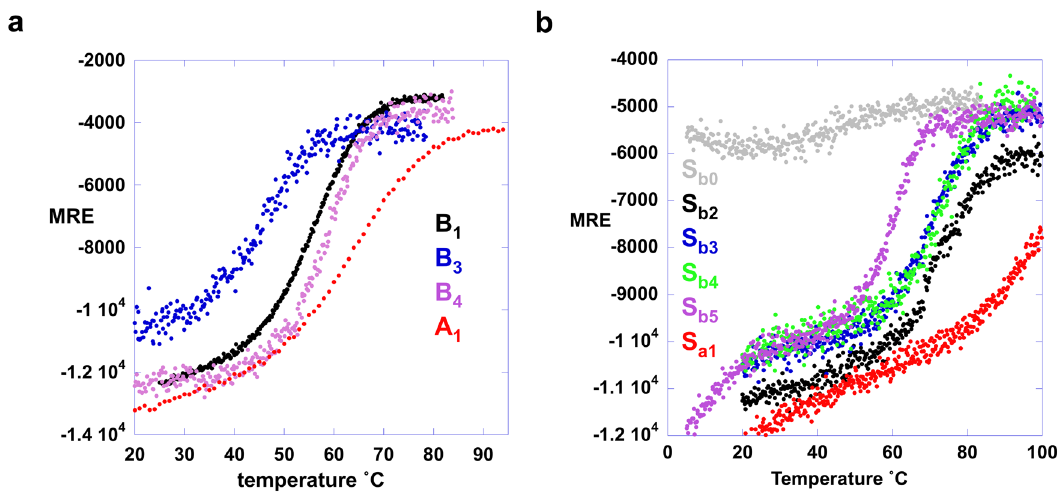
Fig. 5 | CD melting curves. a Ellipticity at 222nm plot versus temperatureforA- and B- variations. b Ellipticity at222nm plot versus temperaturefor S-variations. S b0 isa low-stability variant (F7V) of S b1 used to measure the temperature dependence of the unfolded state. Source data are provided as a Source Data fi le.